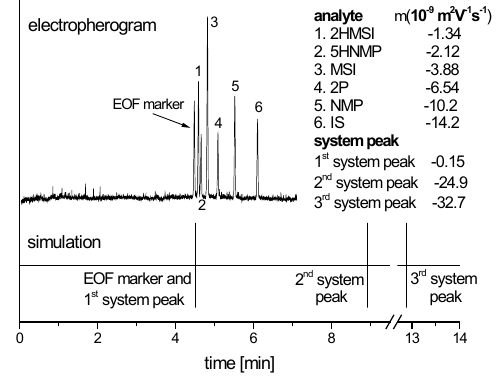
Figure 4. Calculated positions of three system peaks in SDS- phosphate BGE (140 mM SDS, 5 mM phosphate, pH 7.1, electric field strength 400 V cm -1 ) by the simulation program PeakMaster [38]. Positions are depicted as straight vertical lines. Experimental separation of NMP and its metabolites under the same running conditions occurs in the “safe region” without interference of system peaks. Inlay shows experimental electrophoretic mobilities of the analytes and calculated electrophoretic mobilities of the system peaks.